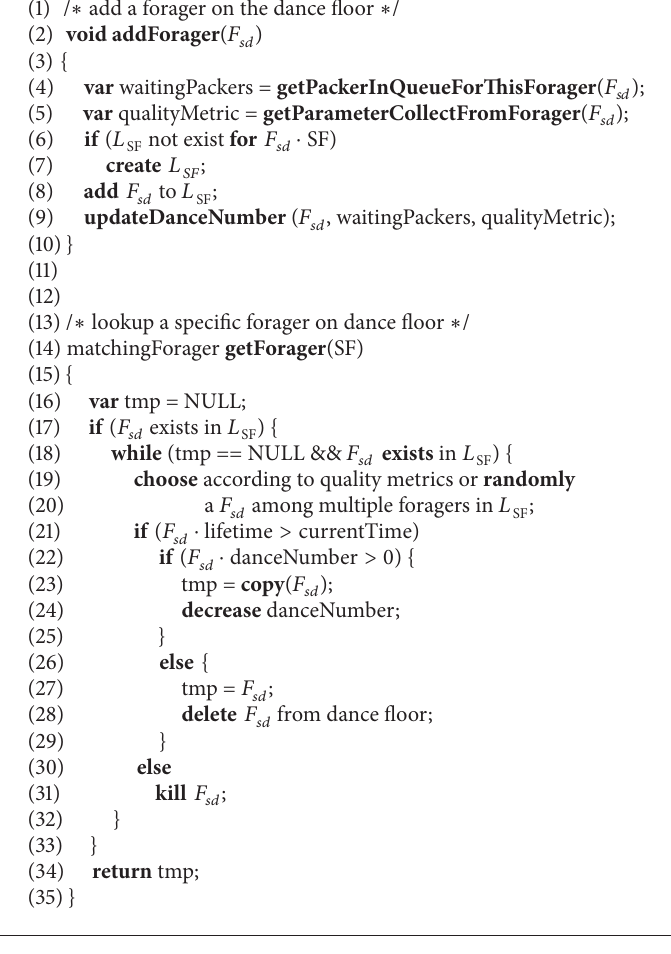
Algorithm 1: Services provided by the Dance